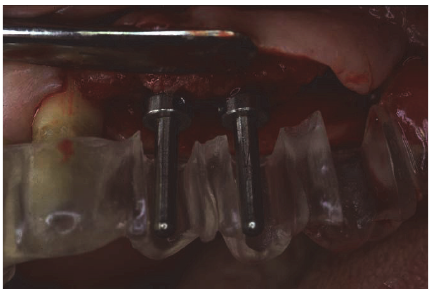
Figure 16: Surgical stents were fabricated based upon the informa- tion from the CT scan and using the diagnostic wax-up.